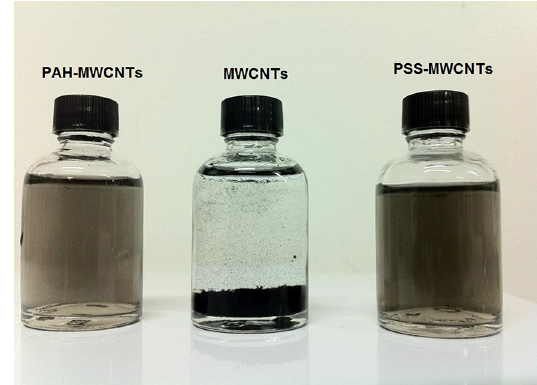
and PSS-MWCNTs-SiO , 2 2